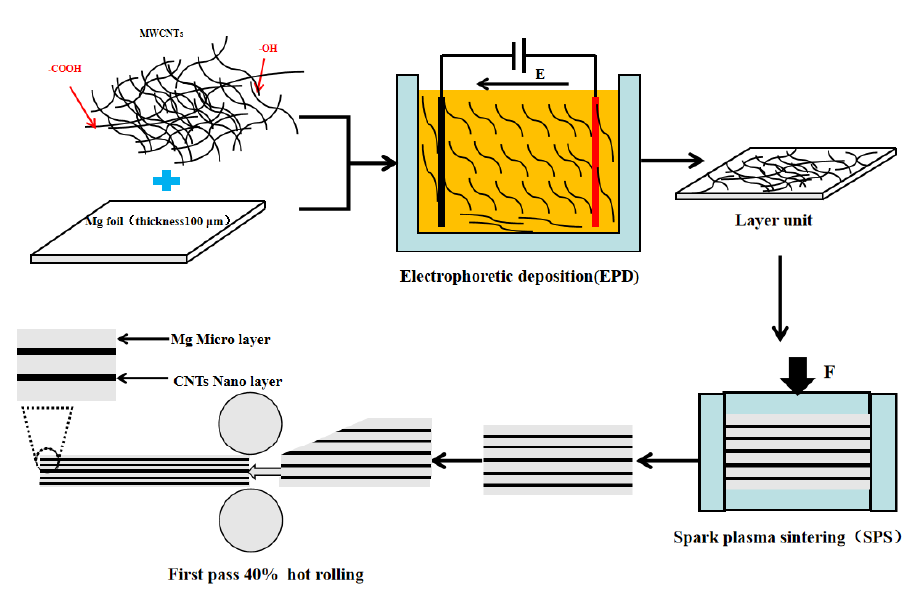
Figure 1. Schematic diagram of the fabrication process of CNTs/Mg laminated composites.